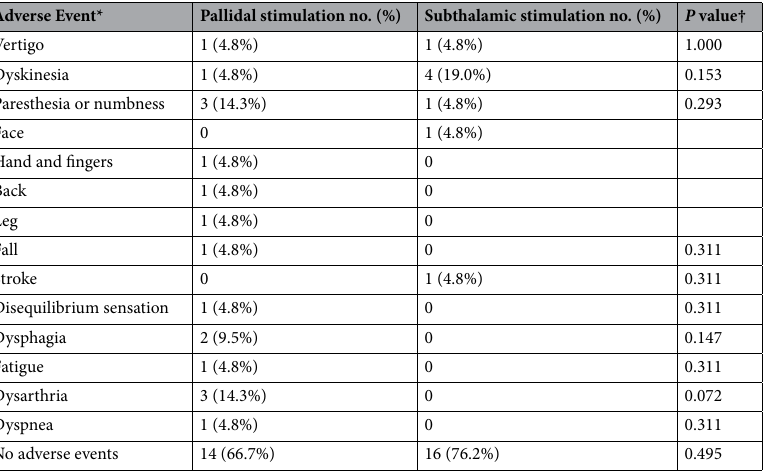
Table 6. Adverse Events at 12 Months. *All events are listed according to the definitions used in the Medical Dictionary for Regulatory Activities, version 14.0, for serious adverse events and moderate or severe adverse events. † χ 2 or Fisher’ s exact test when